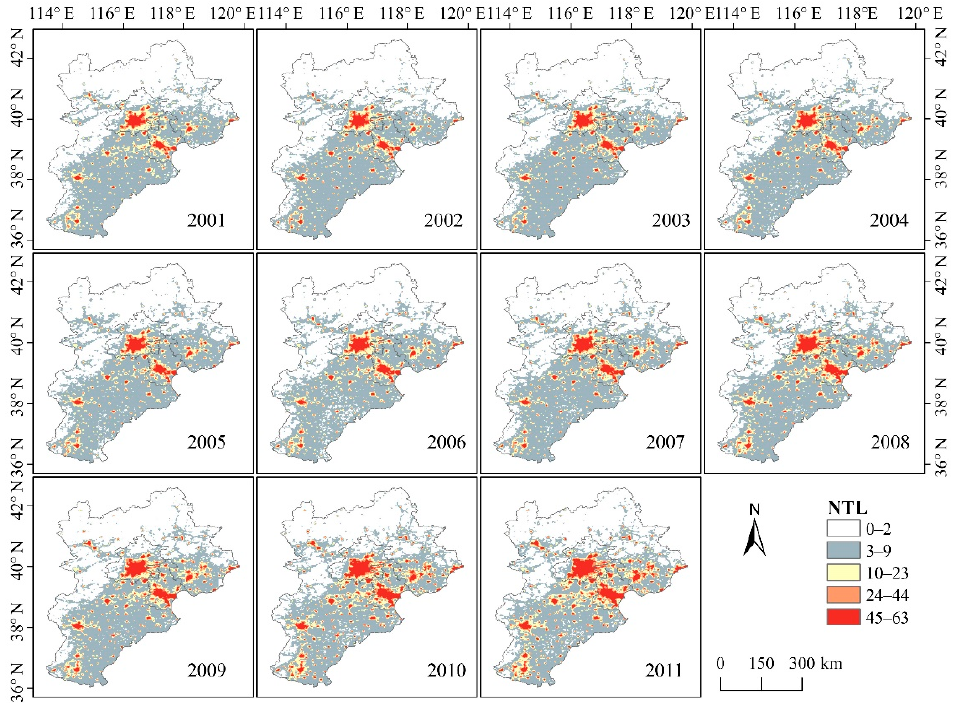
Figure 4. Changes in urban areas from 2001 to 2011. The value represents urbanization intensity.